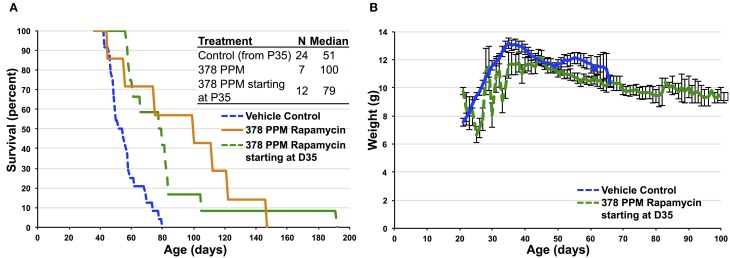
Impact of high-dose dietary rapamycin on
Ndufs4
−/− mice when initiated at P35. (A) High-dose rapamycin provides some benefit to survival when initiated at P35 without impacting developmental weight (B). Control animals in (A) only include those surviving past P35. Survival of mice treated starting at P35 is significantly greater than control treated animals (p = 0.0002, Log-rank test).